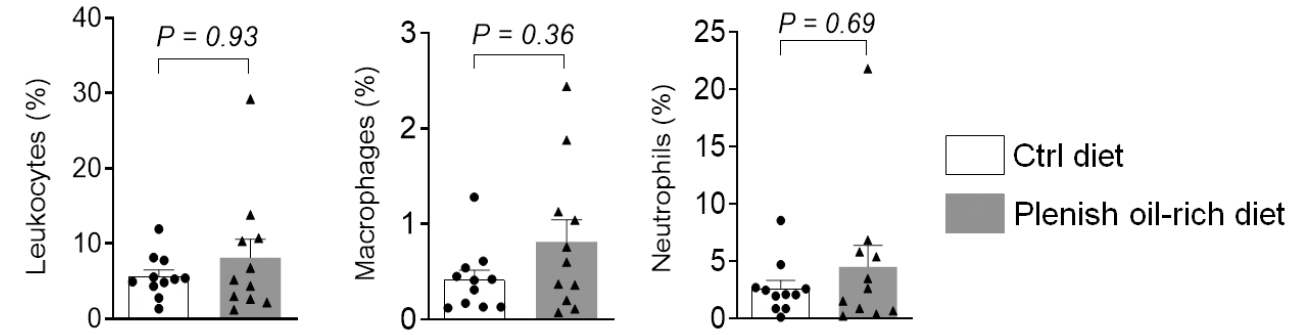
Figure 2. Quantification of immune cells in colon. The results are expressed as mean ± SEM, n = 11 mice per group.